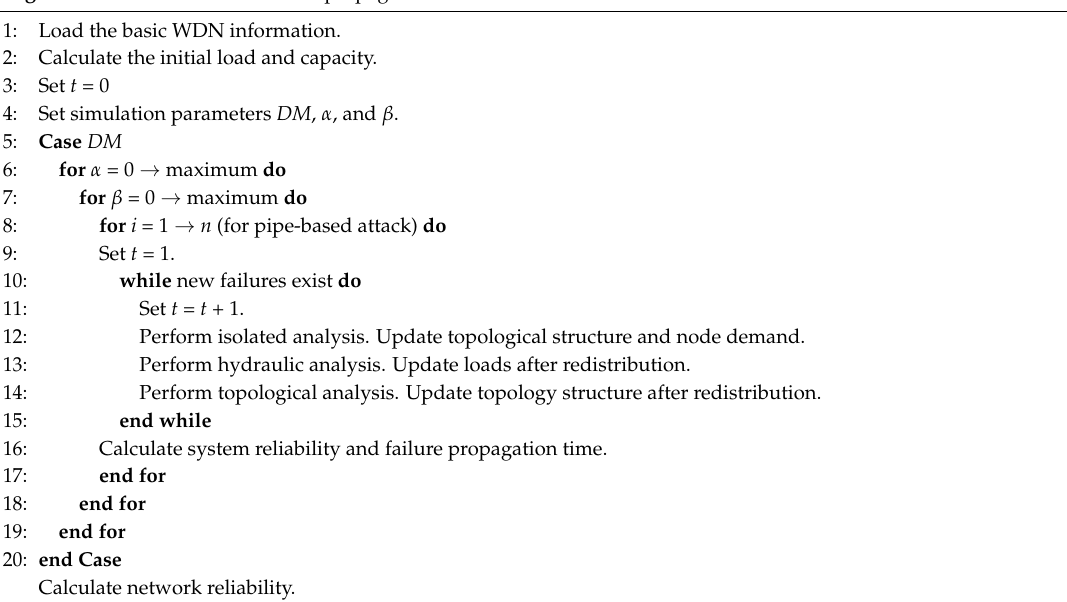
Algorithm 1. Simulation of cascade propagation in a